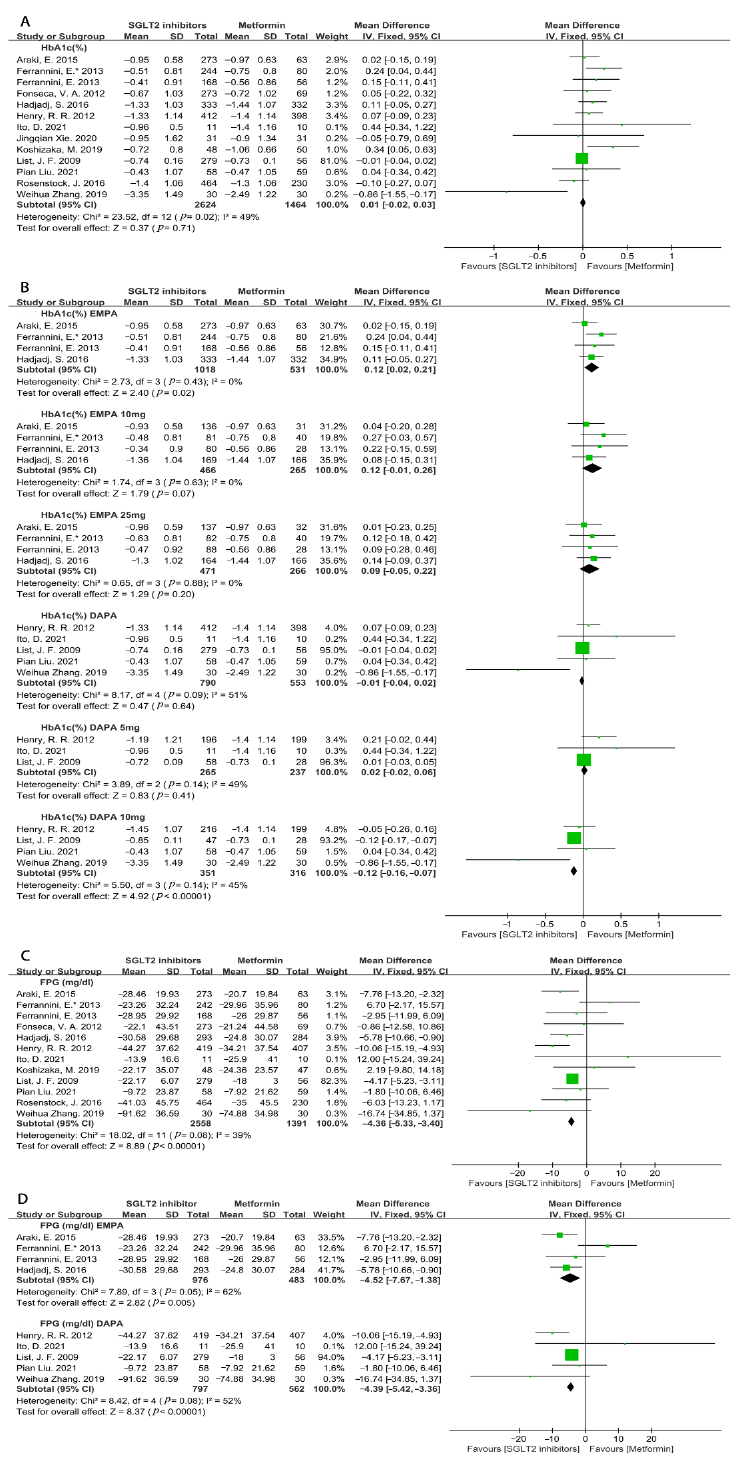
Figure 15. ( A ). Weighted mean differences in change in HbA1c (%) from baseline between SGLT2i and metformin [20–32]. ( B ). Weighted mean difference in change in HbA1c (%) from baseline from different types and doses of SGLT2i compared with metformin [20–28]. ( C ). Weighted mean difference in change in FPG (mg/dL) from baseline from SGLT2i compared with metformin [20–29,31,32]. ( D ). Weighted mean difference in change in FPG (mg/dL) from baseline from different types of SGLT2i compared with metformin [20–28]. DAPA = dapagliflozin, EMPA =